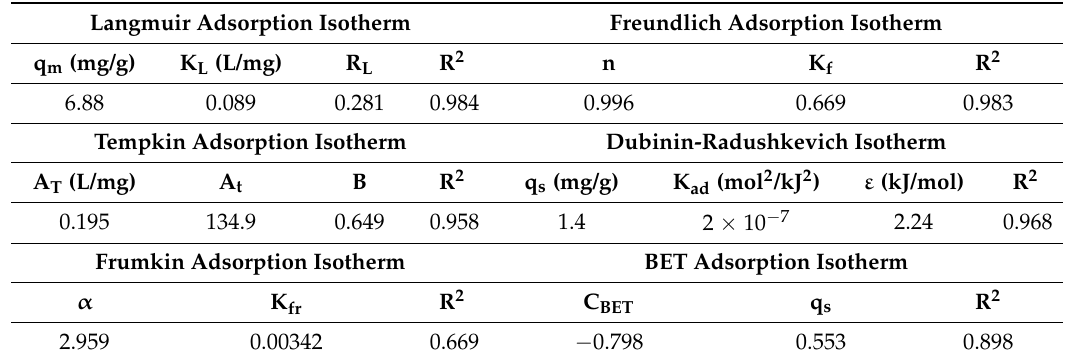
Table 4. Adsorption Isotherm constants for P adsorption by